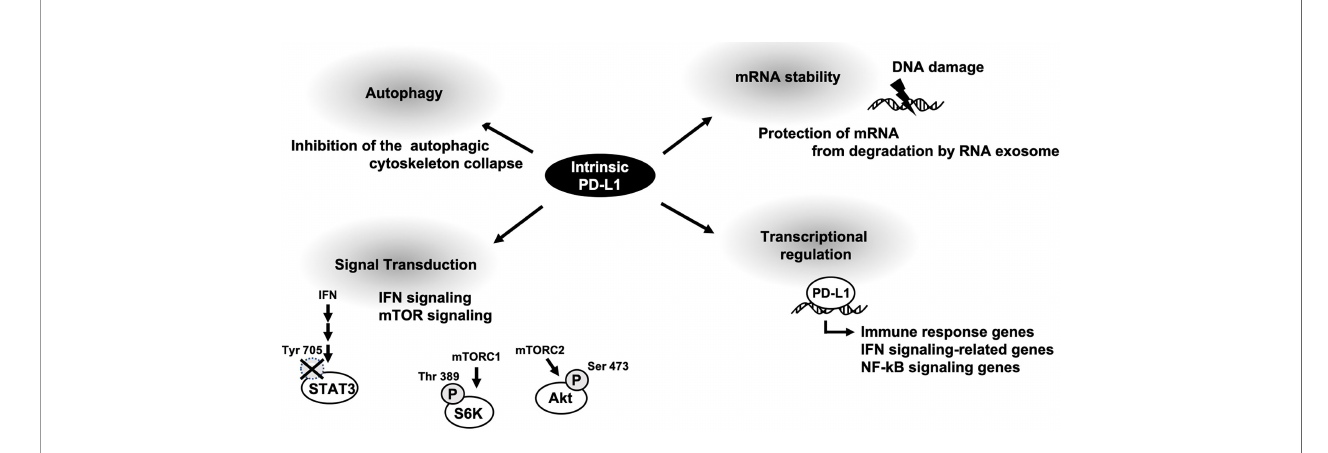
FIGURE 2 | A schematic diagram of cellular